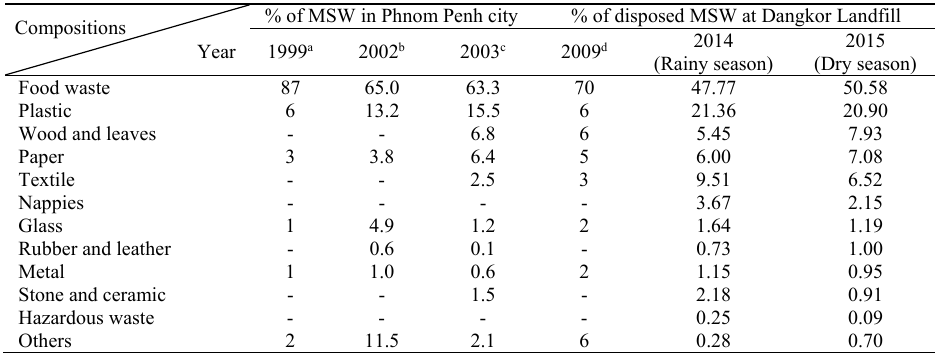
Table 2: Variation of municipal solid waste compositions